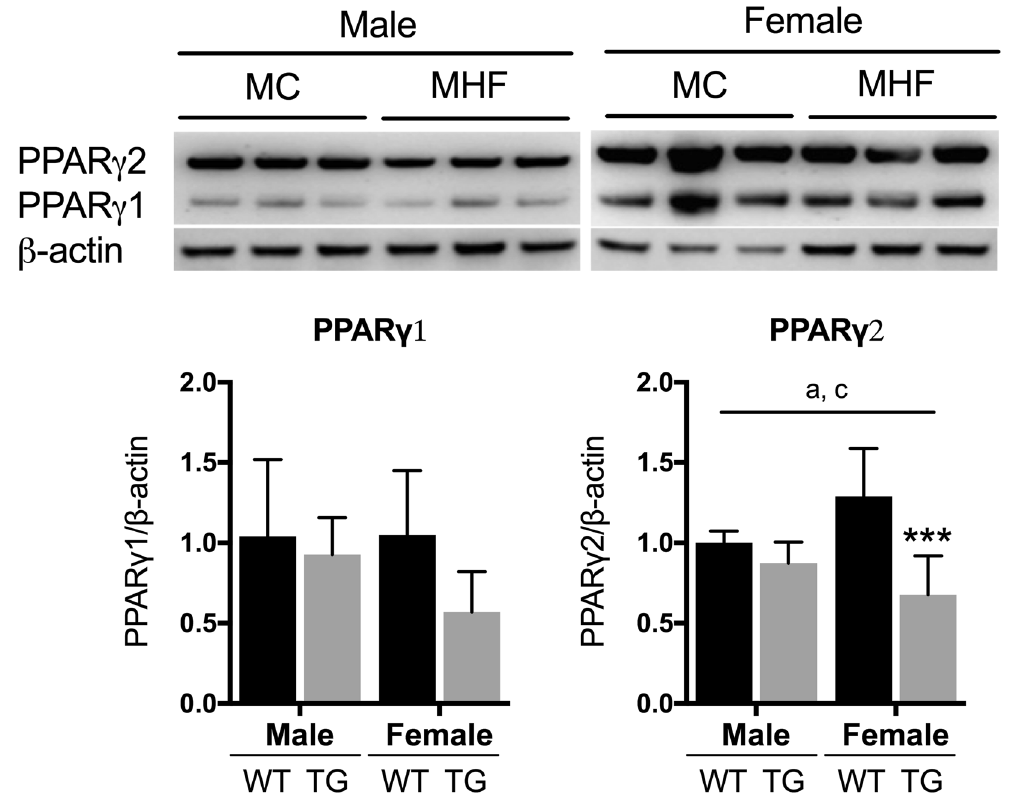
Figure 3. Protein levels of renal Peroxisome proliferator-activated receptor gamma isoform 1 and 2 in male and female offspring. MC (offspring of dams fed chow); MHF (offspring of dams fed high-fat diet). Results are expressed as mean ± SD. Data were analysed by two-way ANOVA followed by Bonferroni post hoc test. ( a ) (P < 0.05, Maternal diet effect), ( c ) (P < 0.05, interaction effect), ** P < 0.01 (vs MC offspring). n =